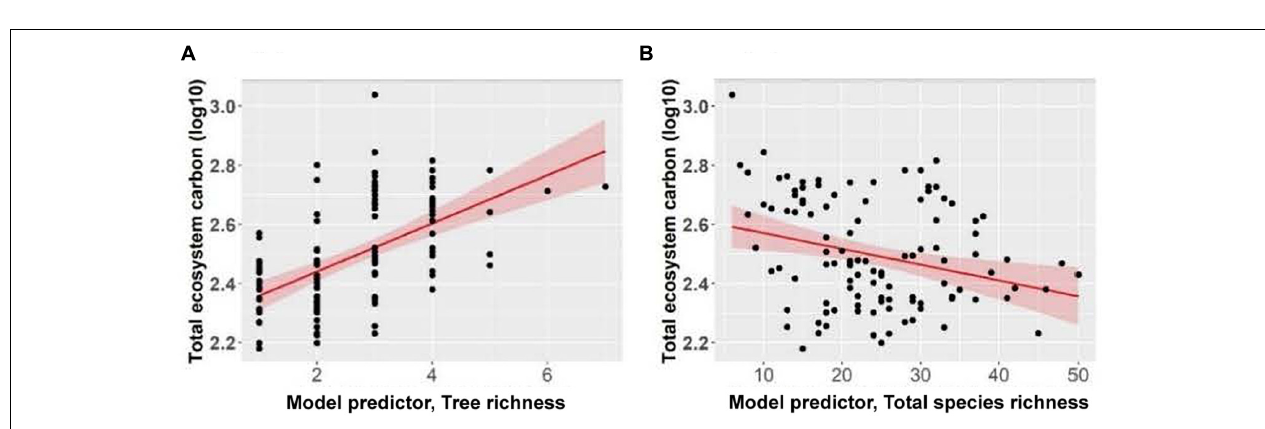
FIGURE 7 | Effect of panels (A) tree richness and (B) total species richness on total ecosystem carbon of Douglas-fir dominated forests. Each point represents one measurement per plot (113 plots in total). Total ecosystem carbon (Mg ha − 1 ) was log 10 -transformed, and the figure presents log 10 -transformed data.